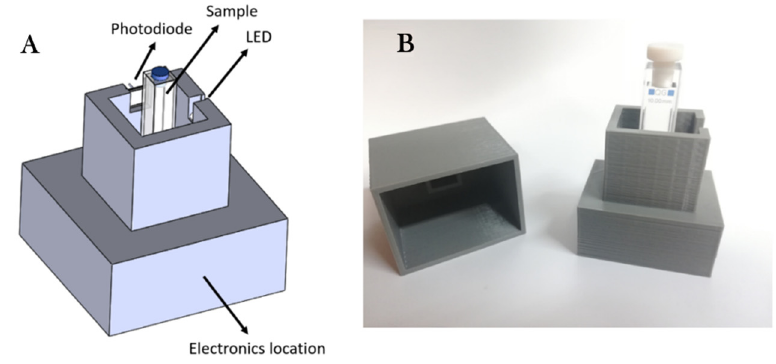
Figure 7. A 3D model ( A ) and real view ( B ) of the final portable instrument.